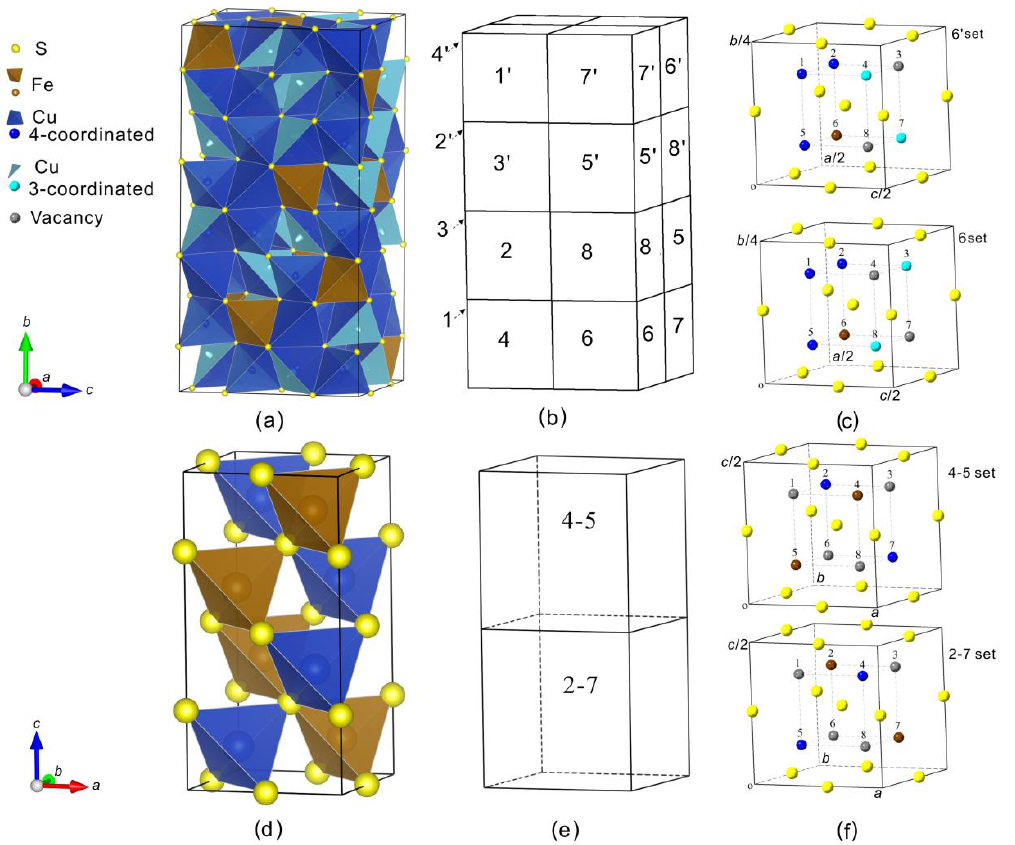
Figure 3. Cube stacking models for the structure of bornite ( a – c ) and chalcopyrite ( d – f ) [5]. ( a , d ) Fe-S and Cu-S tetrahedra and Cu-S triangles in the unit cell. ( b , e ) cube stacking prism with cube labels indicating the position of Fe and the vacancy. ( c , f ) example cubes showing the locations of Fe atoms, Cu atoms, and the vacancy in the 8 interstitial sites of F-centered S atoms.